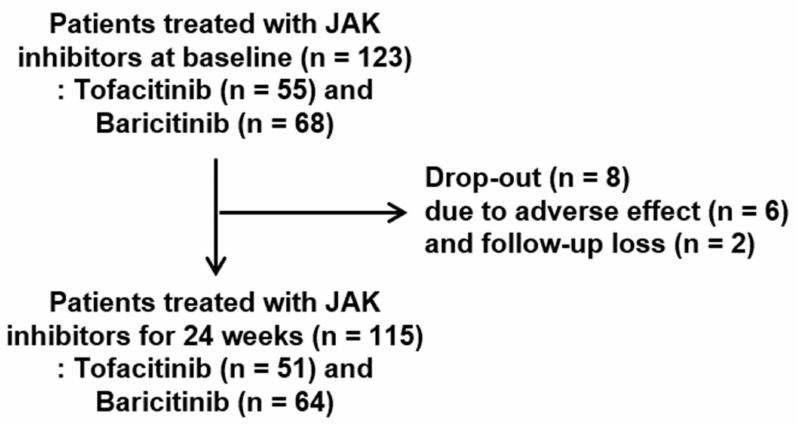
Figure 1. Study population flow chart. Abbreviation: JAK, Janus